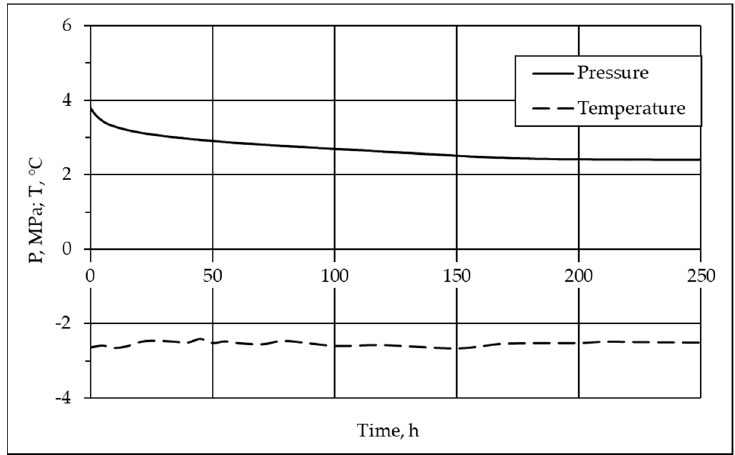
Figure 2. Record of thermobaric conditions during the hydrate formation in sample silt 2 ( W = 20%, Si = 59%) at t = − 2.5 ◦ C.